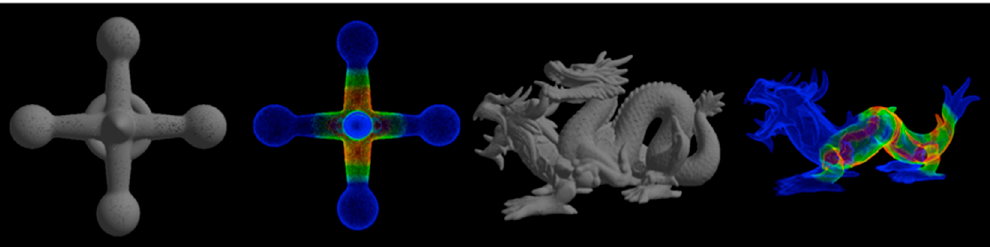
Figure 5. Examples of the color assignment for visualizing the collision risks between point-based surfaces. The left images show the collision of a hub surface with a torus. The hub surface is colored. The right images show the collision between two types of dragons. The dragon with horns is colored.